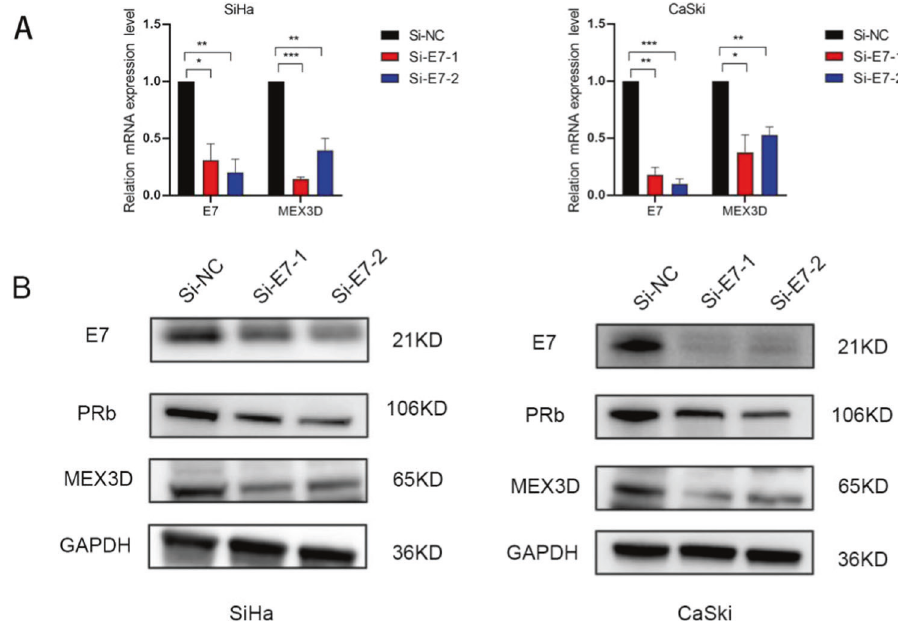
Fig. 6 HPV16 E7 stimulates MEX3D expression in cervical cancer cells. A Levels of MEX3D mRNA expression were analyzed by qRT-PCR in SiHa and CaSki cells underwent transfection with two E7 siRNAs and si-NC. B Protein levels of MEX3D, E7 and pRb were determined following transfection with two E7 siRNAs and si-NC. * P < 0.05, ** P < 0.01, and *** P <